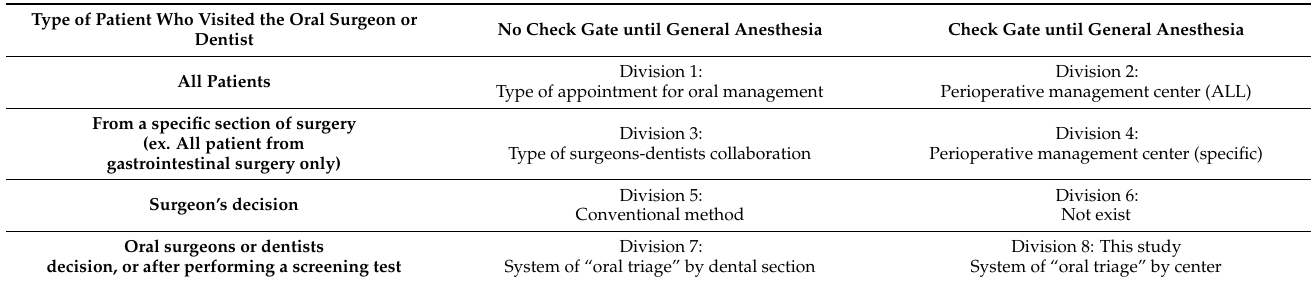
Table 7. Classifications of the Japanese Oral Management system for